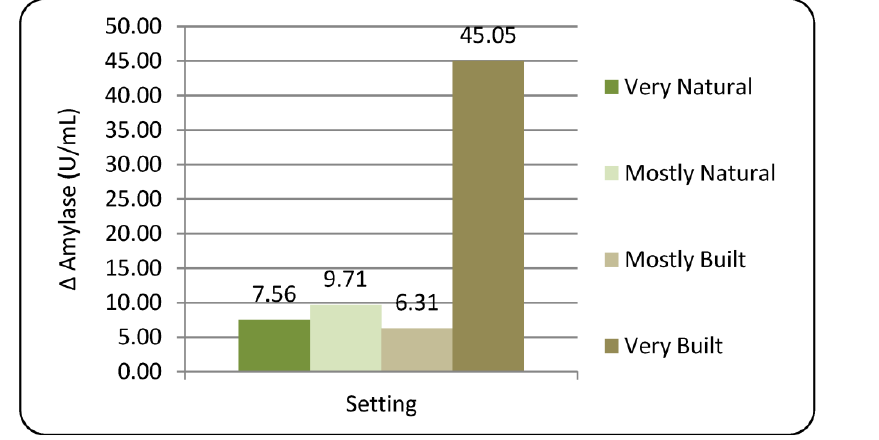
Figure 3. Changes in salivary amylase (∆Amylase) after 20 min exposure to environmental